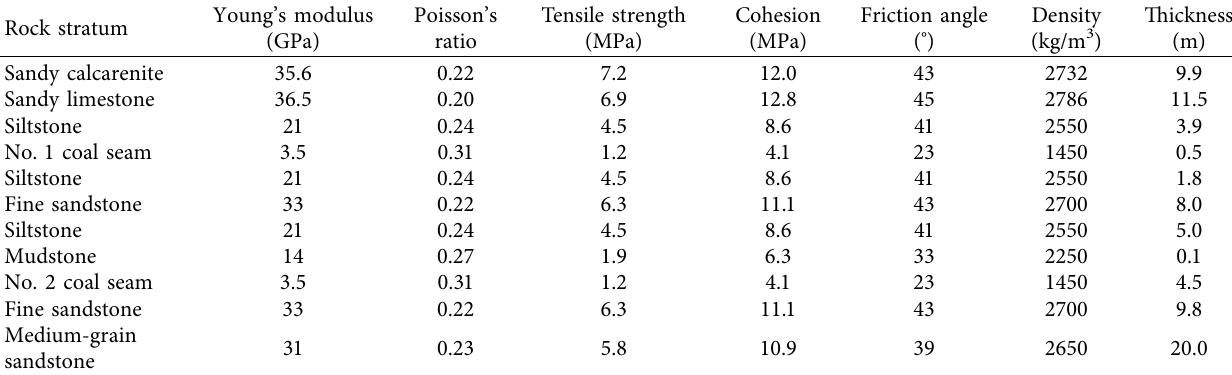
Table 1: Mechanical properties of rock mass applied in the model.